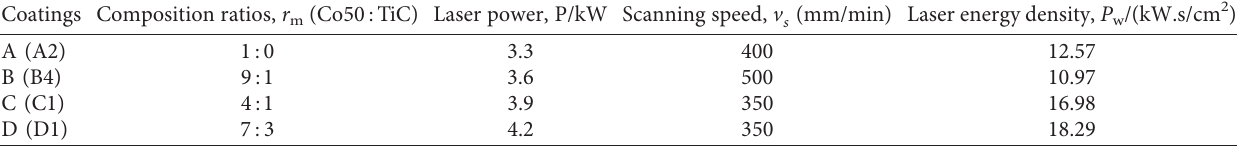
Table 9: Preparation parameters and the corresponding sample